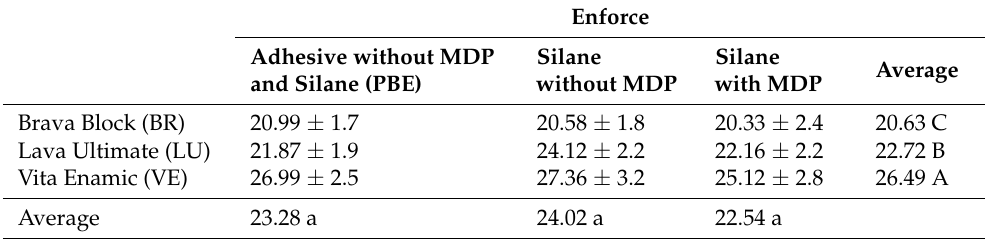
Means followed by different letters (uppercase letters within column; lower case letters within row) are signifi- cantly different (pre-set α =